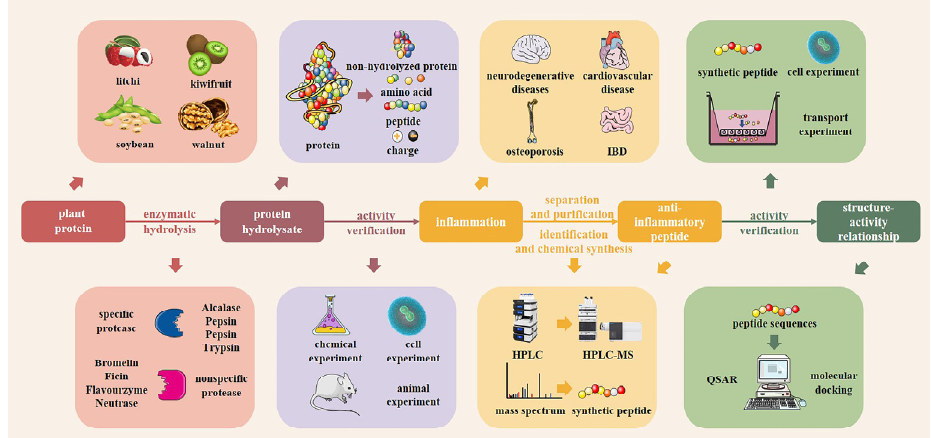
Figure 4. Processing, activity verification and mechanism investigation of plant-derived anti-inflammatory peptides.